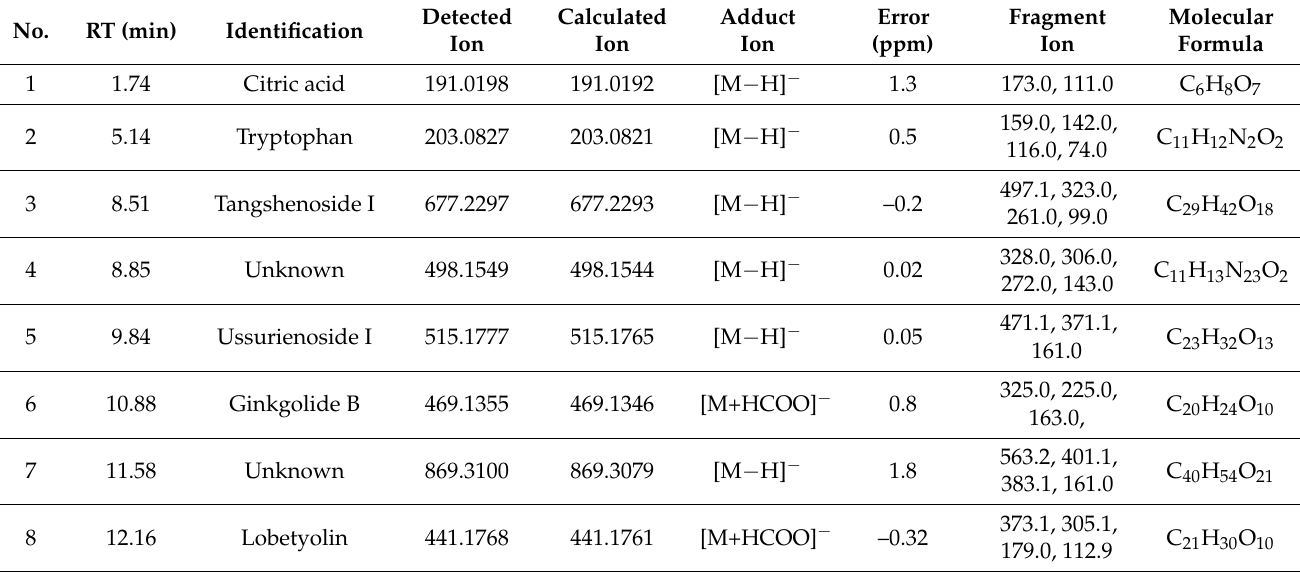
Figure 4. LC-QTOF-MS chromatograms of compounds of C. ussuriensis root extract. ( a ) PDA spectra; ( b ) MS spectra; ( c ) Tangshenoside I; ( d ) Ussurienoside I. Table 2. Compounds of C. ussuriensis root extract identified using